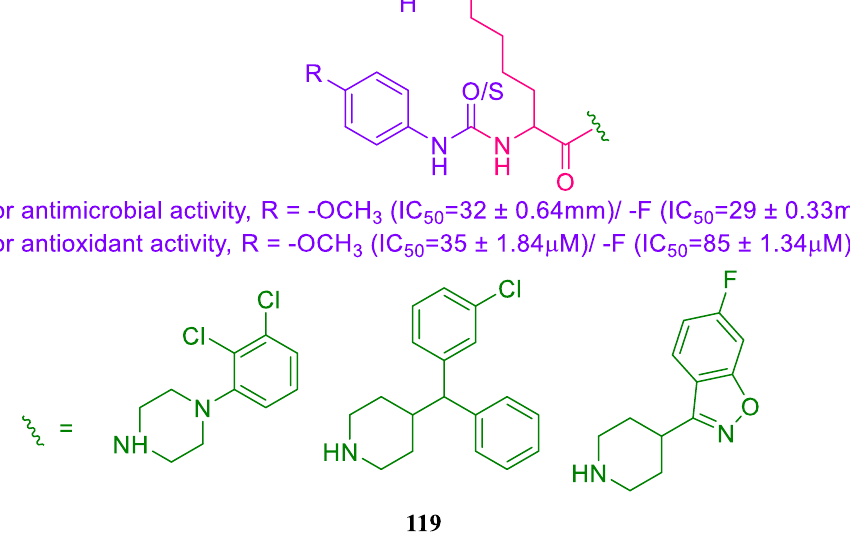
Figure 97. Lys-conjugated